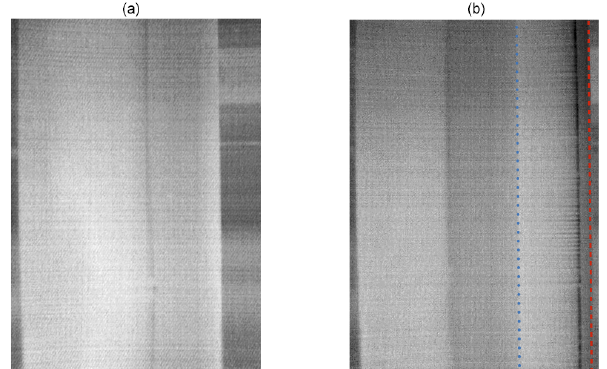
Figure 10. Infrared images of the suction side of the clean main air- foil (i.e. no tripping) at an angle of attack α = 10 ◦ : without slat (a) and with slat under configuration A (b) . In panel (b) , the red dashed line indicates the slat leading edge, whilst the blue dotted line shows the slat trailing edge. Flow is going from right to